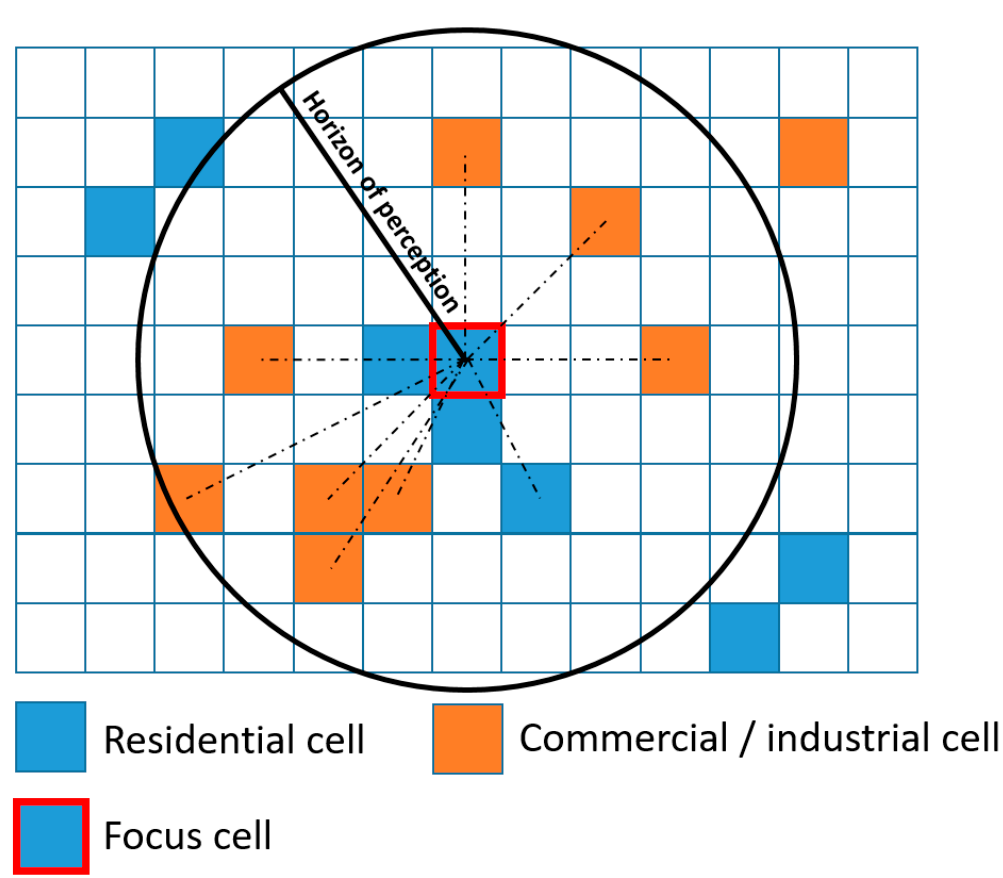
Figure 3. Illustration of the horizon of perception. Built-up cells located within a circle of radius equal to the horizon of perception around the focus cell directly affect its perceived sprawl.